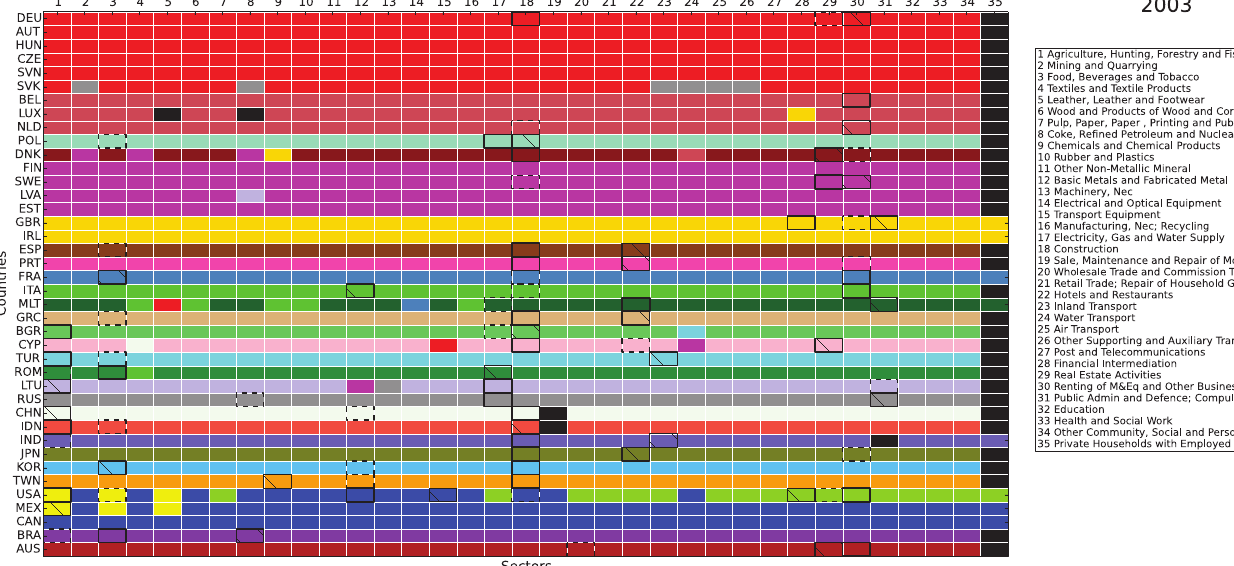
Fig 9. Community detection and community core detection results in 2003. The economies are arranged by rows and the industries are arranged by columns. Each color represents a community detected, except that the black color indicates the isolated nodes with only self-loop. Within each community, the top 3 core economy-industry pairs are identified. The first place is with thick and solid border. The second place is with thick and dashed border. The third place is with border and texture.